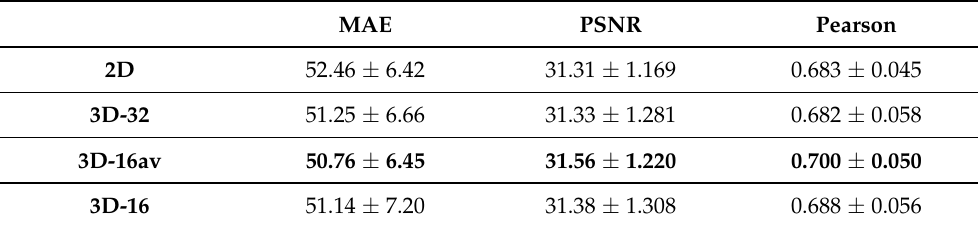
Table 16. Pelvis dataset with U-Net. Mean Absolute Error, PSNR and Pearson coefficient from U-net using different convolutions and reconstructions in the Pelvis data set.